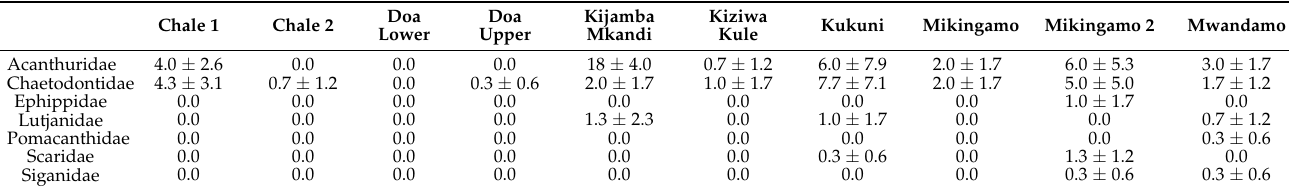
Table 1. Mean number of fish families per site ± standard